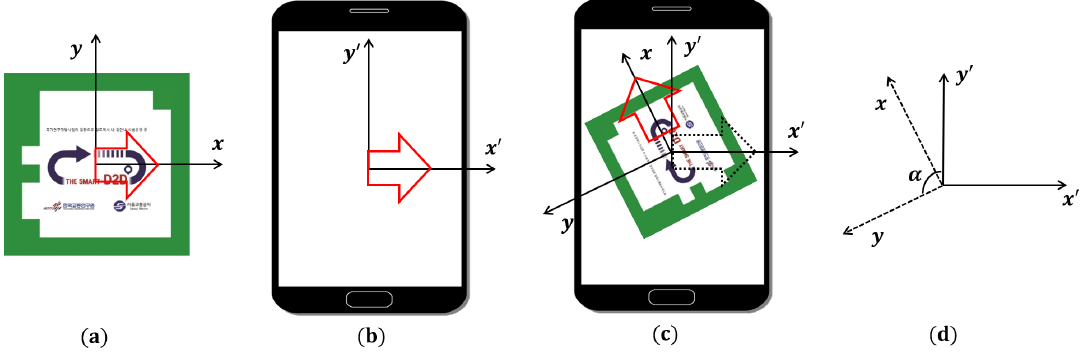
Figure 7. Direction re-calculation procedure of the HMIPS: ( a ) marker-based arrow; ( b ) camera screen-based arrow; ( c ) difference of the arrows; ( d ) angle